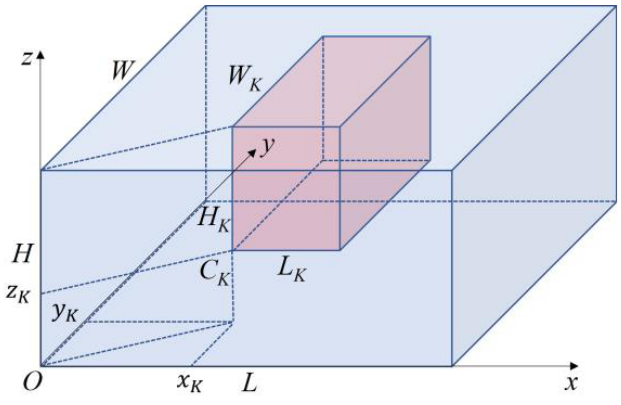
Figure 1. The position of the space K in the bin.